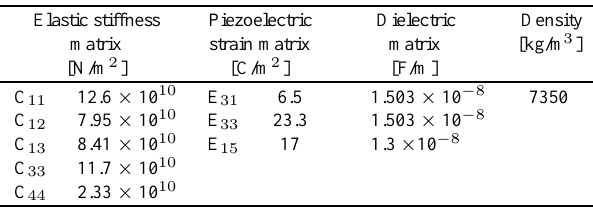
Table 2 Material properties of the PZT patches (PZT-5H)